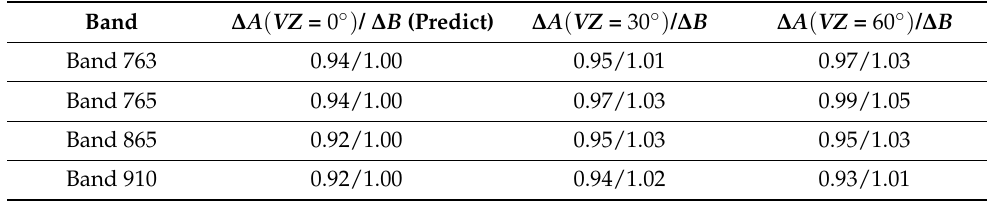
Table 3. The locations of the SNESs selected in our calibration.